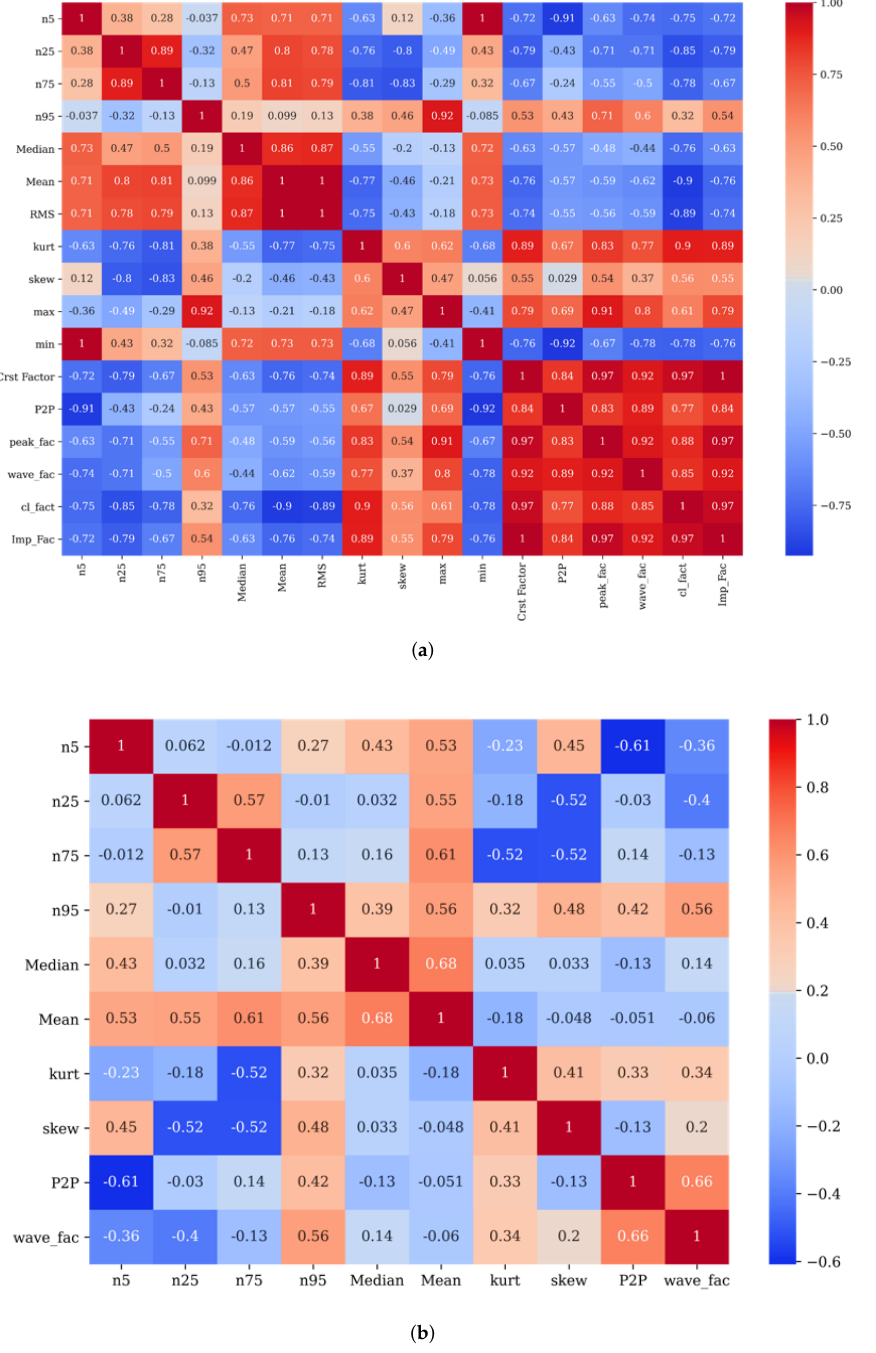
Figure 10. A filter–based correlation plot of features: ( a ) all 17 extracted features and ( b ) 10 discriminant –selected